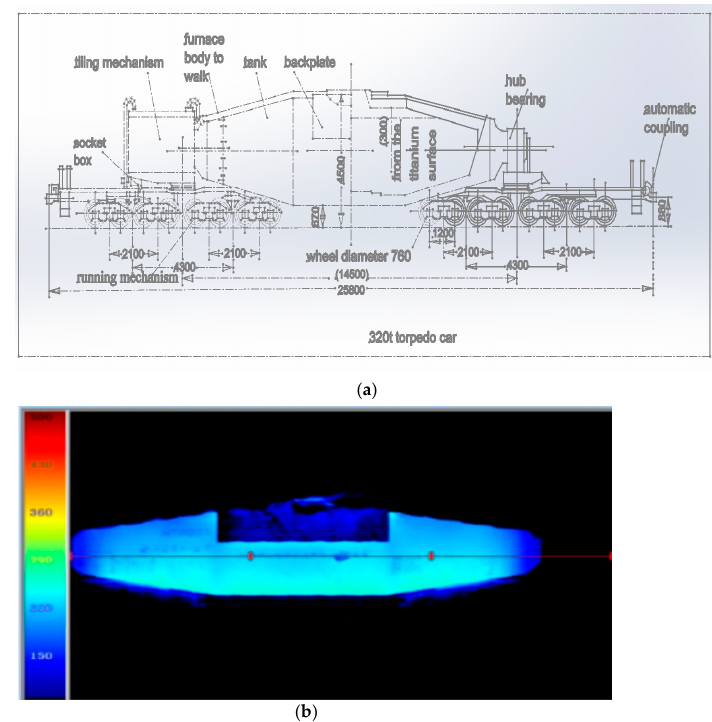
Figure 6. ( a ) Mechanical diagram of 320 t torpedo car, ( b ) thermal imaging.